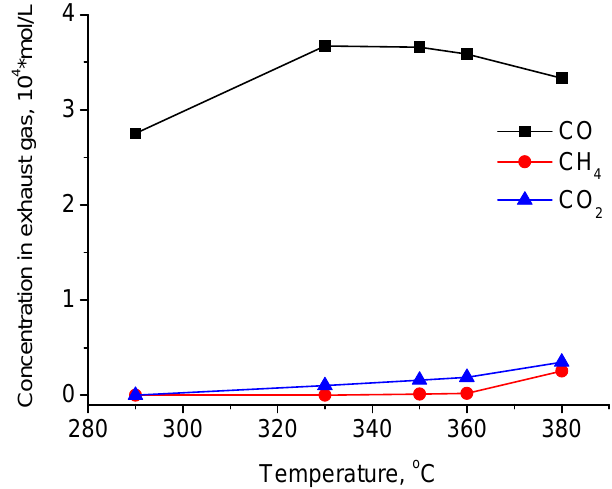
Figure 11. Temperature dependence of the exhaust gas composition during lauric acid HDO over l ‐ Ni1P2 catalyst. Reaction conditions: feed composition 7.41 wt % lauric acid in n ‐ octane, P H2 = 3.0 MPa, T = 290—380 °C, H 2 /feed = 600 Nm 3 /Nm 3 , LHSV = 2.16 h − 1 .